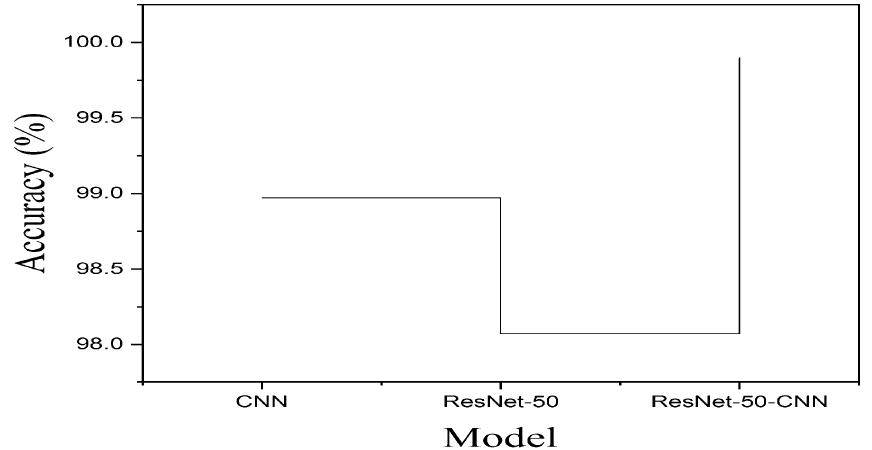
Figure 4. CNN, ResNet-50 and Integrated (ResNet-50-CNN) models accuracy comparison with augmented Brain tumor data set. The CNN model obtained accuracy’s with augmented data is 98.97%, while ResNet-50 obtained 96.07% and Integrated model ResNet-CNN obtained high predictive accuracy 99.90% with augmented data. Thus, the proposed integrated ResNet-CNN model is suitable for effective classification of brain tumors and could assist clinical professionals to diagnosis brain cancer accurately and efficiently. Due to the high performance of proposed ResNet-CNN method we recommend it for diagnosis of brain cancer in IoT- healthcare.